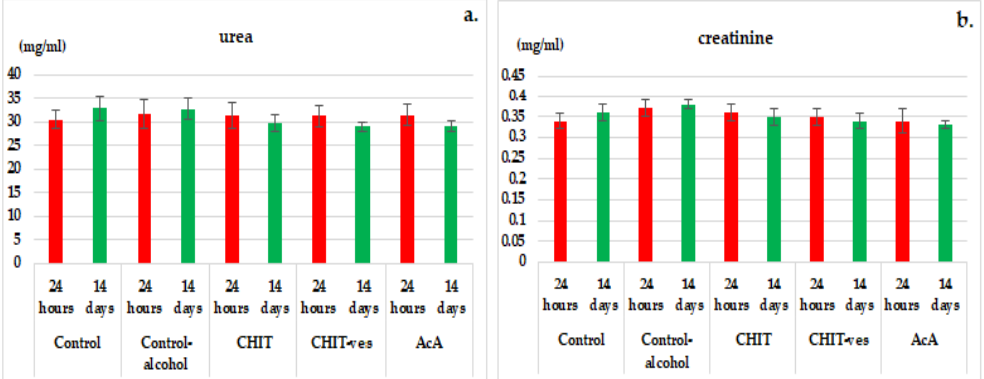
Figure 6. The effects of chitosan, chitosan vesiclesand ascorbic acid on the serum urea ( a ) and creatinine ( b ) levels in mice (mean ± S.D. of the average values—groups of 6 animals).